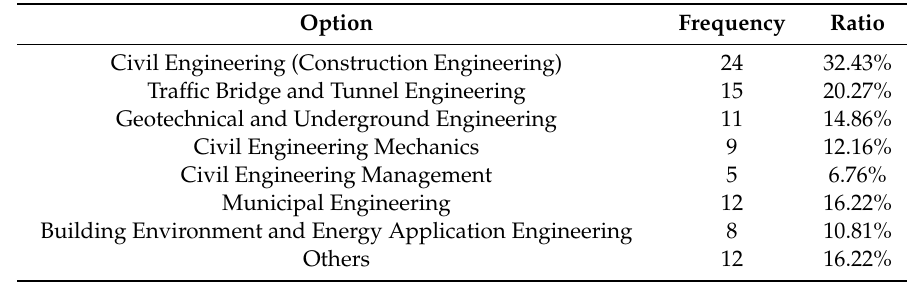
Table 5. Descriptive statistical analysis of lecturers’ teaching specialty information.